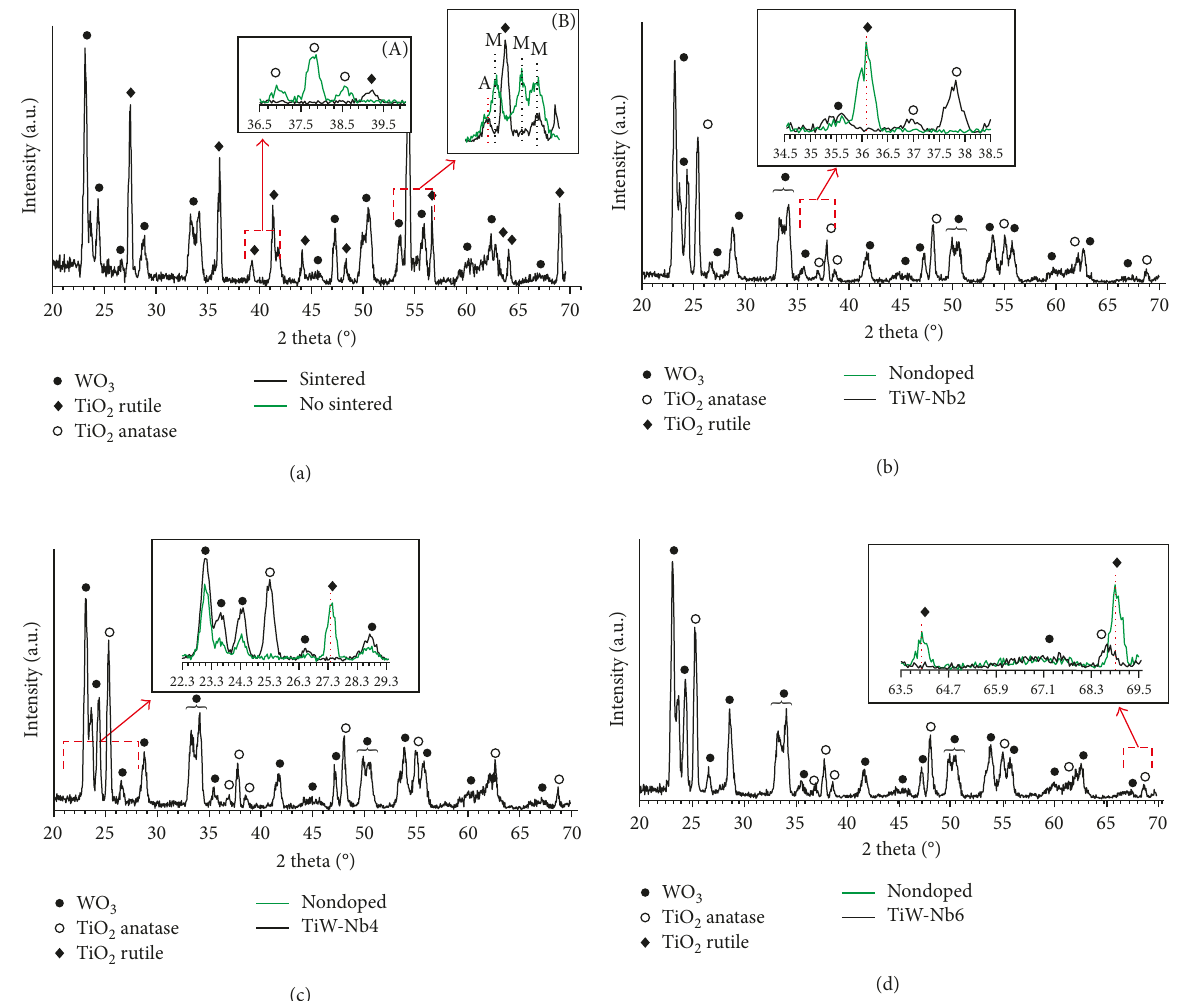
: WO 2 3 -doped sensors with 2% (b), 4% (c), and 6% (d) of Nb 2 O 5